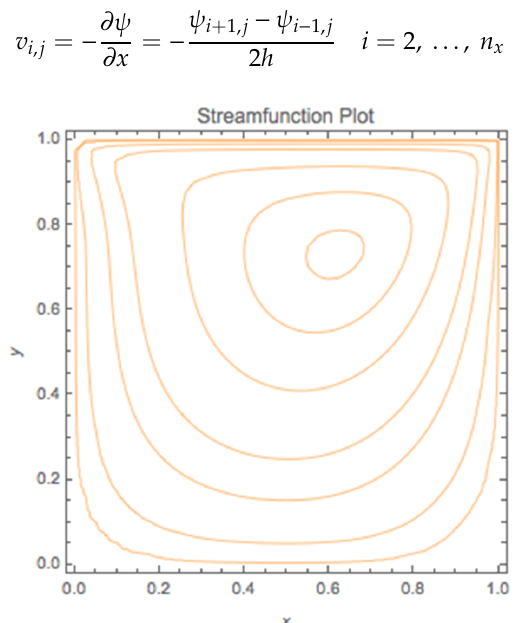
Figure 7. Contour plot of streamfunction for lid-cavity problem. (Reproduced with permission from [22]). Extraction of the centerline velocities was also instructive for the students in that first, students were given more experience of viewing velocity profiles, and second there are ample calculations and measurements of the lid-cavity flow for comparison with their results [25–27]. The centerline